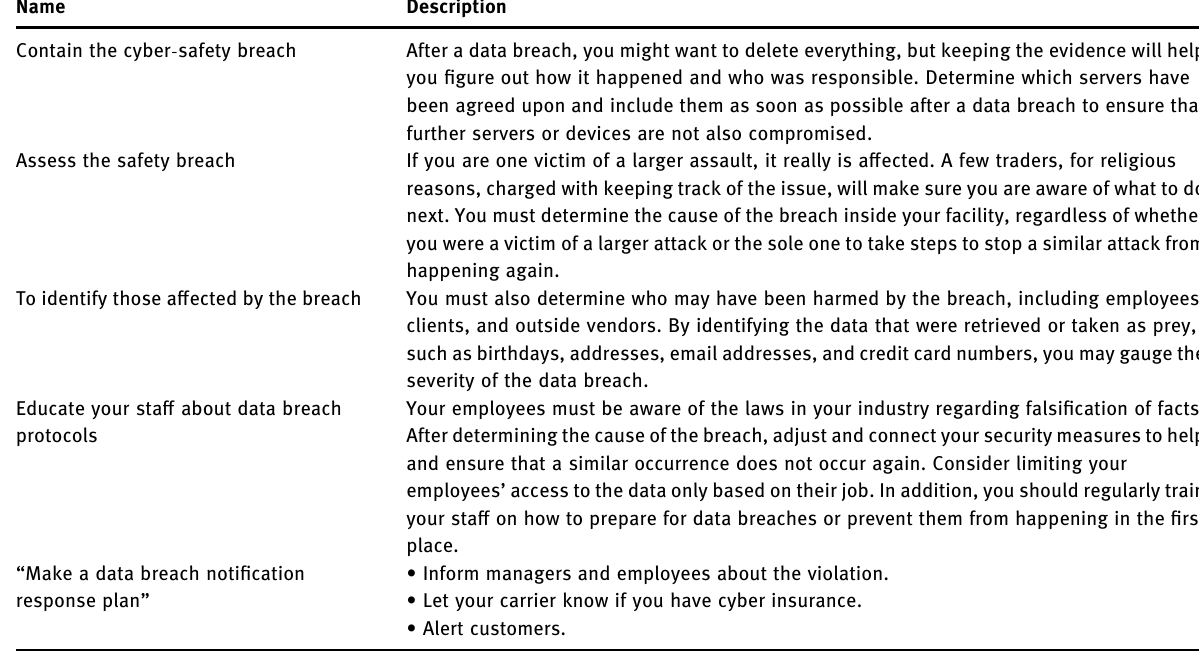
Table 3: Description of various data/safety breaches Name